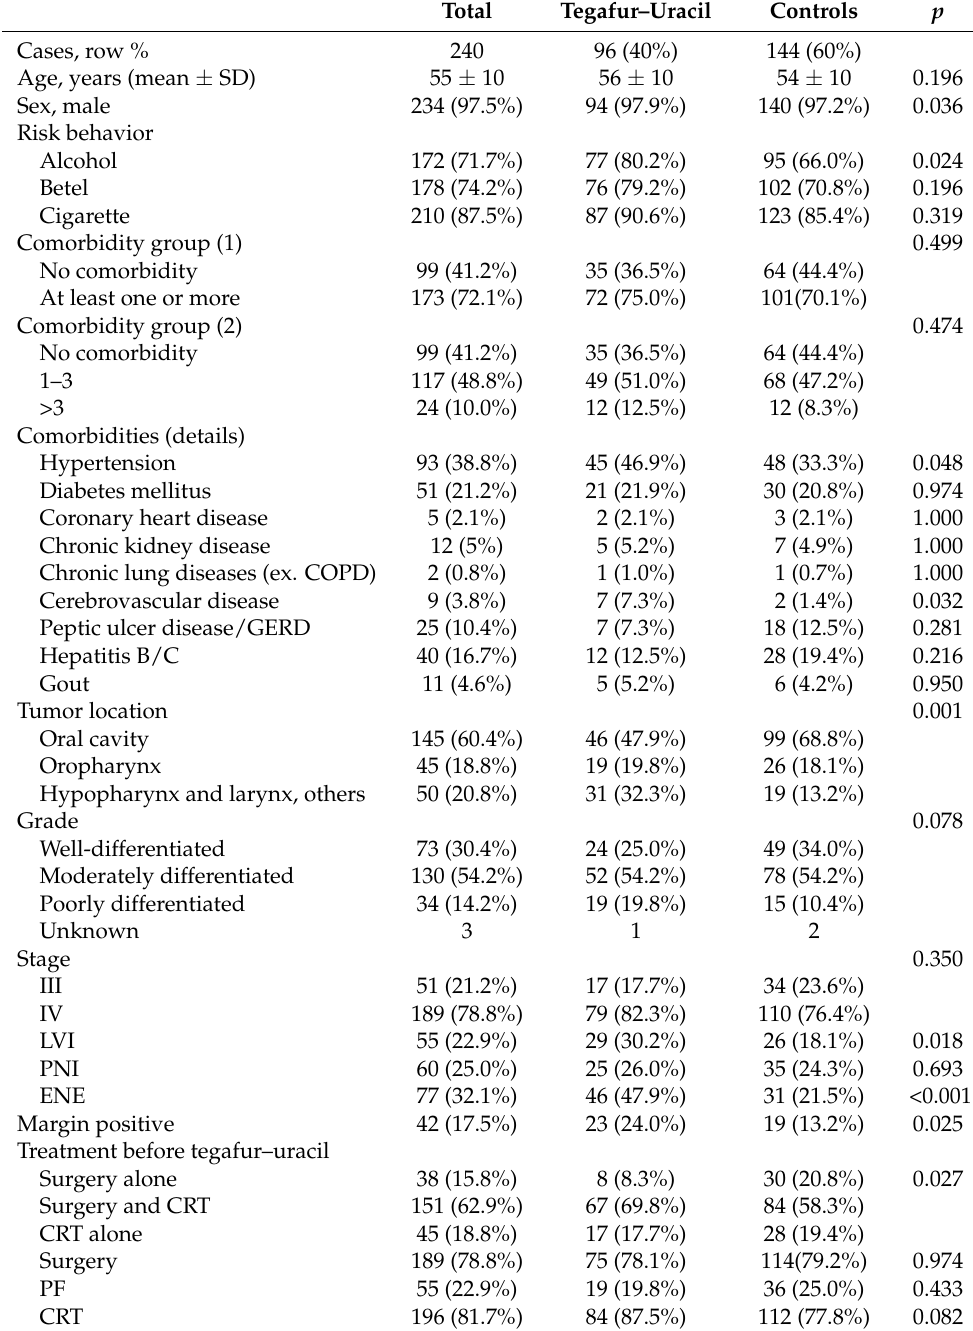
Table 1. Baseline characteristics ( n =